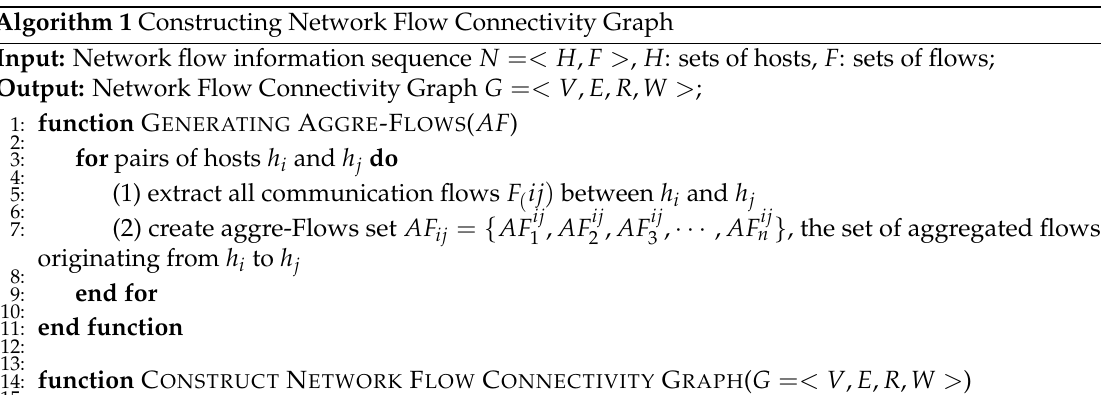
Algorithm 1 Constructing Network Flow Connectivity